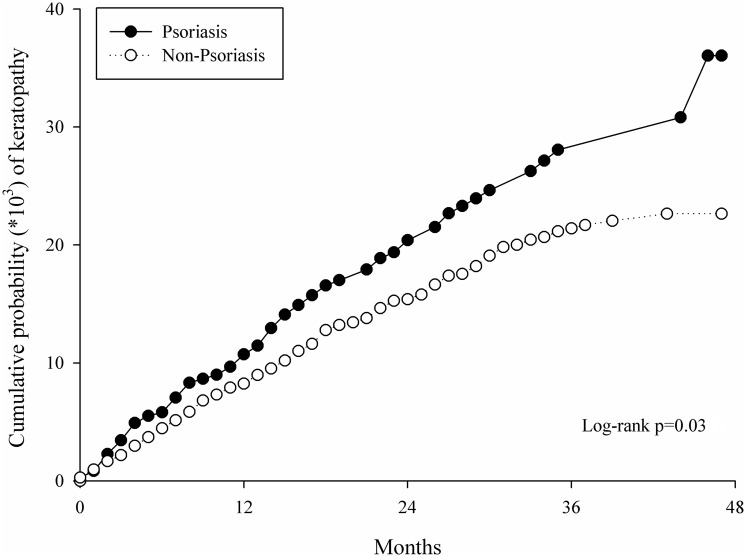
Kaplan-Meier curves with cumulative proportion of keratopathy in the psoriasis and non- psoriasis groups.